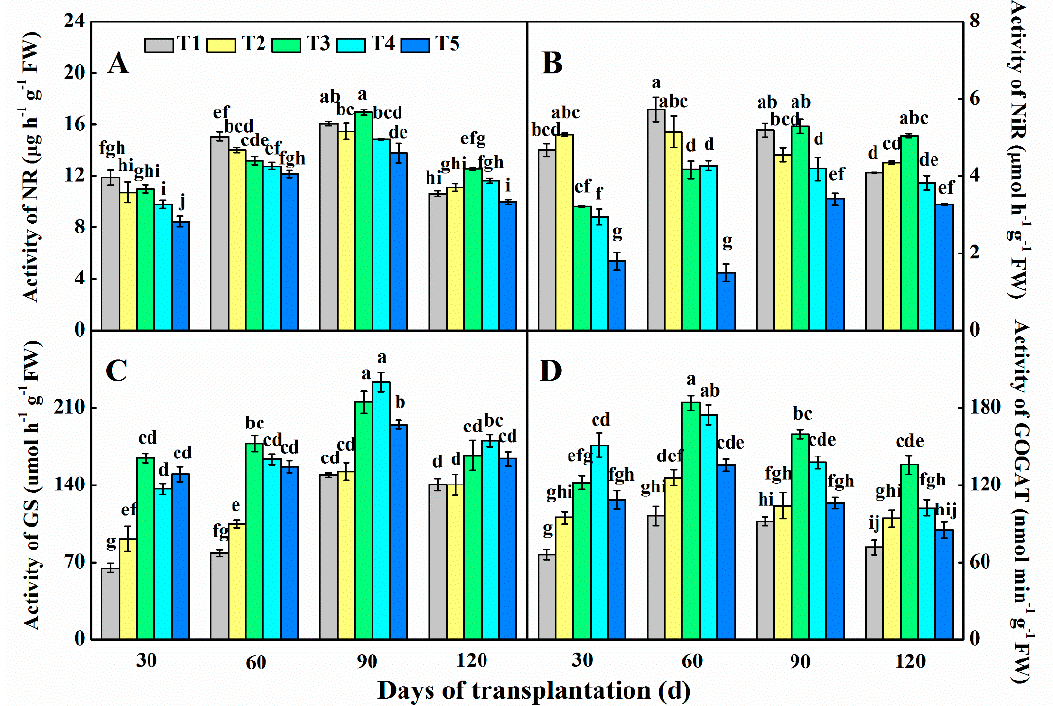
Figure 5. Activities of NR ( A ), NiR ( B ), GS ( C ), and GOGAT ( D ) enzymes in pepper leaves at the different NH 4+ :NO 3 − ratios. Vertical bars represent mean ± SE from three independent replicates and the different letters denote significant differences ( p < 0.05). The five treatments were defined in Figure 1 above. Abbreviations: nitrate reductase (NR); nitrite reductase (NiR); Glutamine synthetase (GS); glutamate synthases (GOGAT).